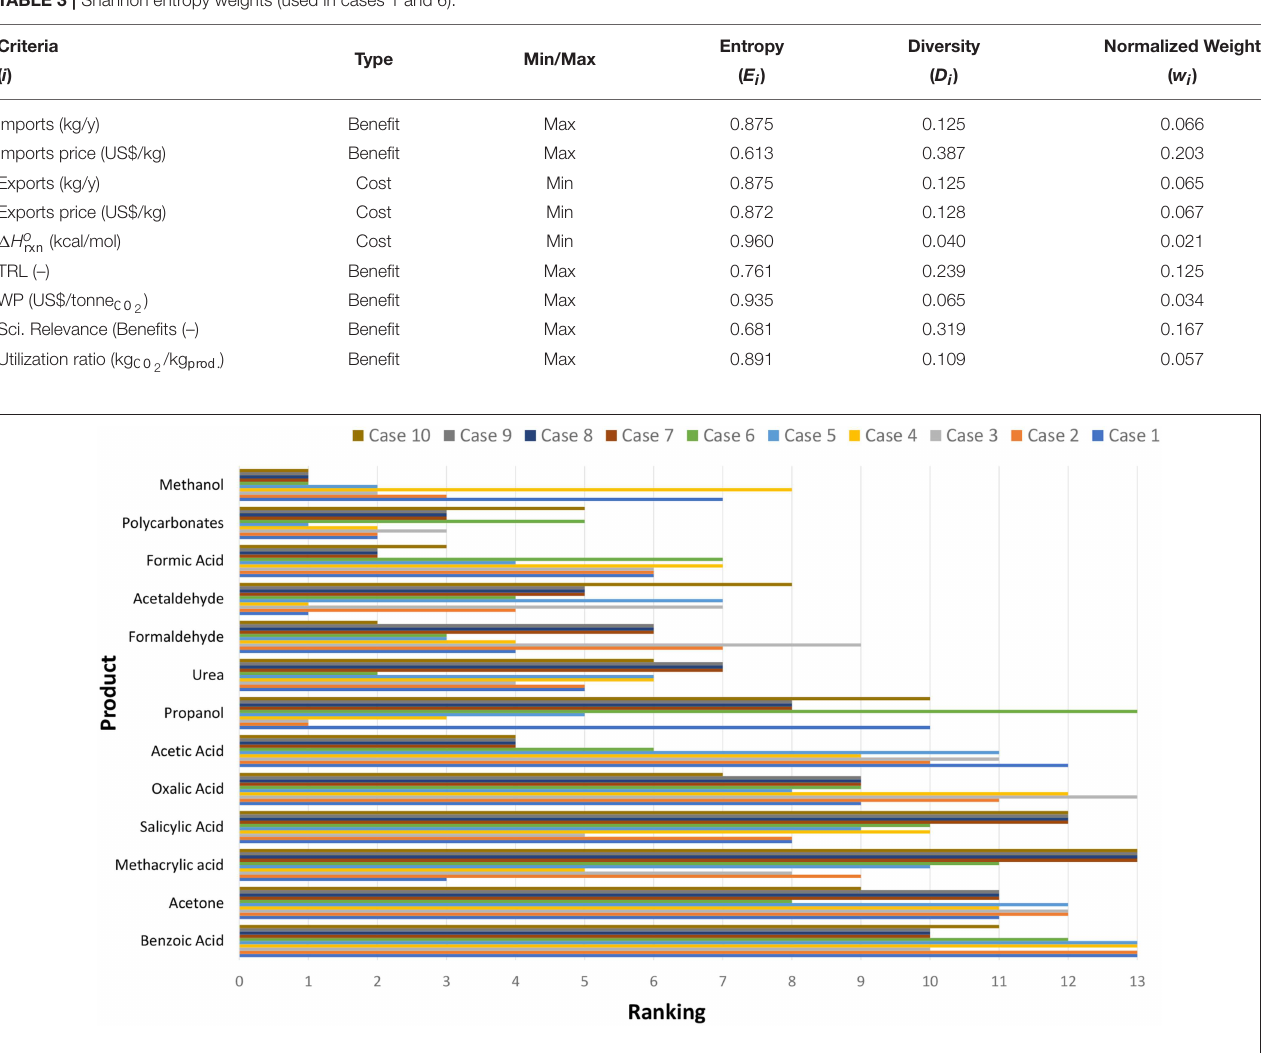
Entropy Diversity Normalized Weight